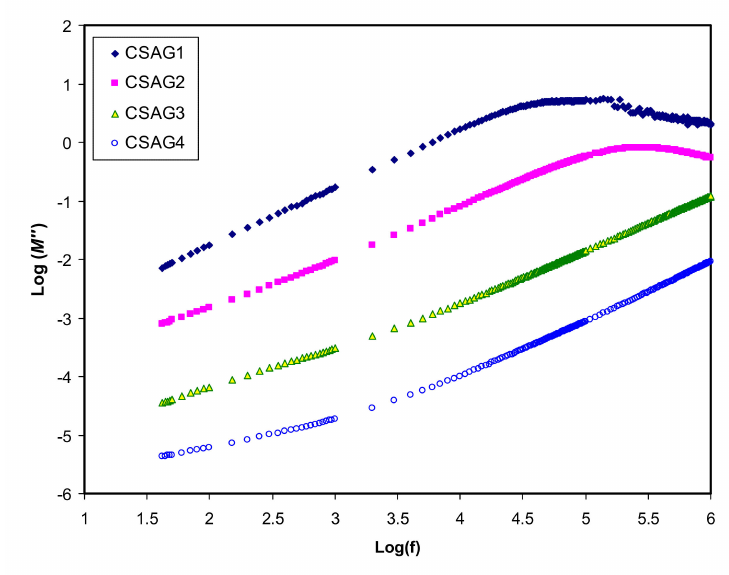
Figure 5. An imaginary part of an electric modulus ( M ”) against frequency for CSAG1–CSAG4 electrolyte systems at room